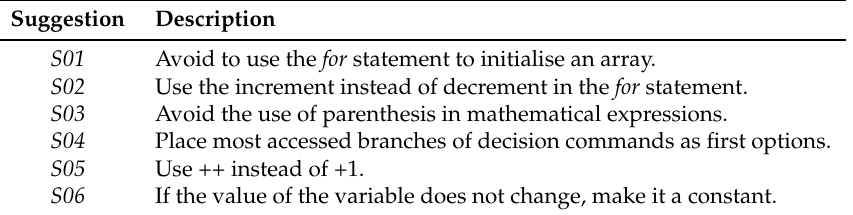
Table 1. Implementation suggestions of Suggestion Component